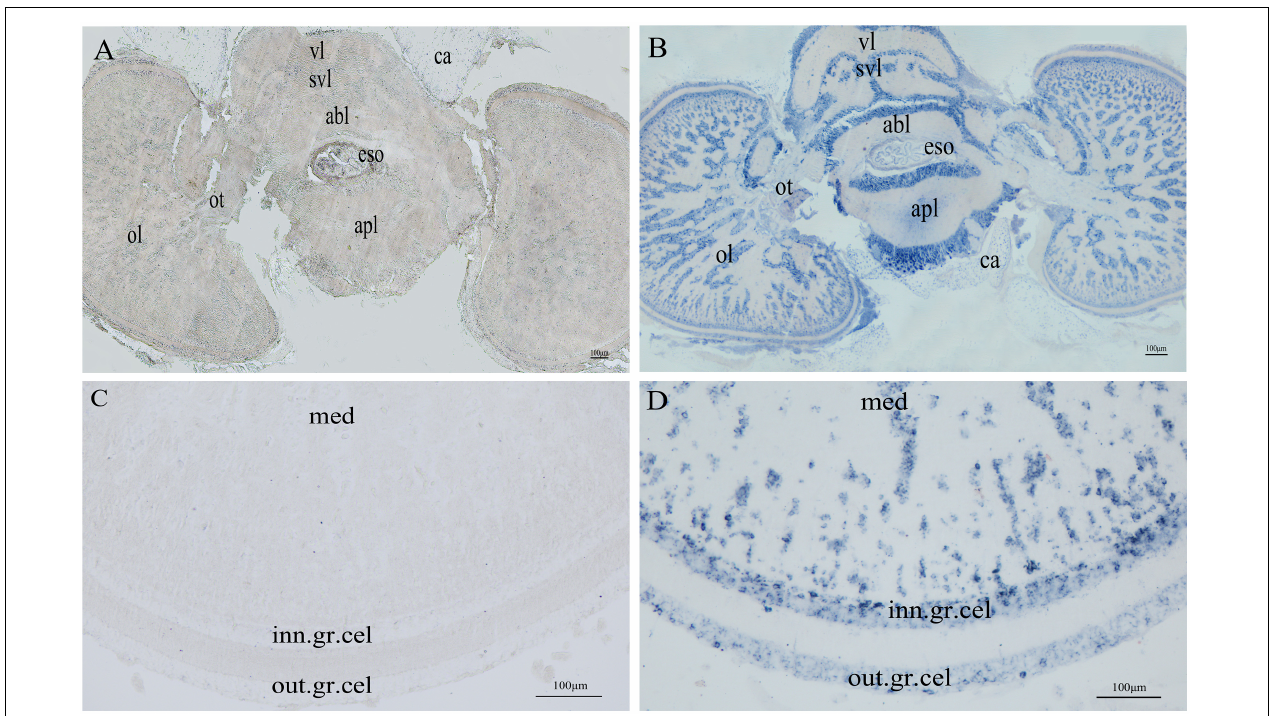
FIGURE 6 | Distribution of SjPRQFVRP mRNA in the brain. (A) The brain of stage I-II was stained with sense SjPRQFVRP probe; (B) The brain of stage I-II was stained with anti-sense SjPRQFVRP probe; (C) The optic lobe was stained with the sense SjPRQFVRP probe; (D) The optic lobe was stained with the anti-sense SjPRQFVRP probe. Vl, vertical lobe; svl, subvertical lobe; abl, anterior basal lobe; eso, esophagus; apl, anterior pedal lobe; ca, cartilage; ot, optic tract; ol, optic lobe; med, medulla; out. gr. cel, outer granulosa cell; inn. gr. cel, inner granulosa